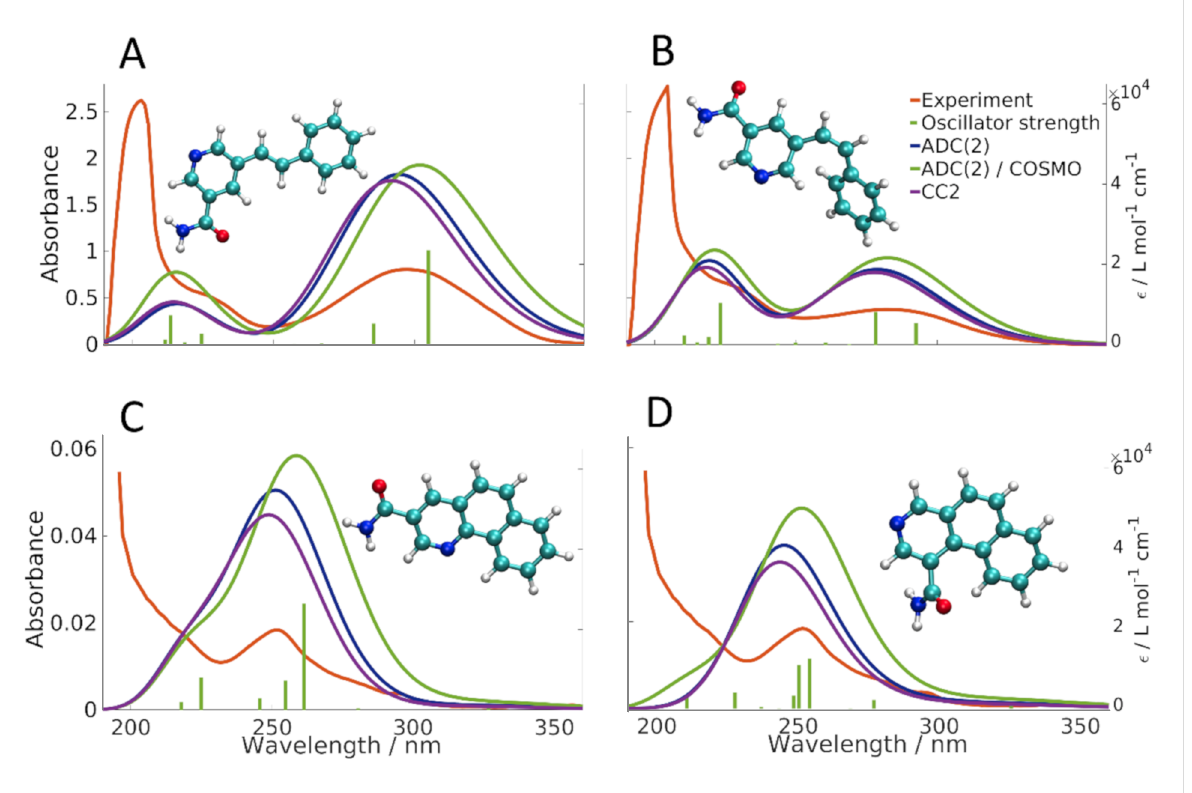
Figure 4: Calculated and experimental absorption spectra of compounds ( E )- 2b-B (A), ( Z )- 2b-A (B), and products 8a (C) and 8b (D). Oscillator strengths (green sticks) correspond to the ADC(2)/COSMO